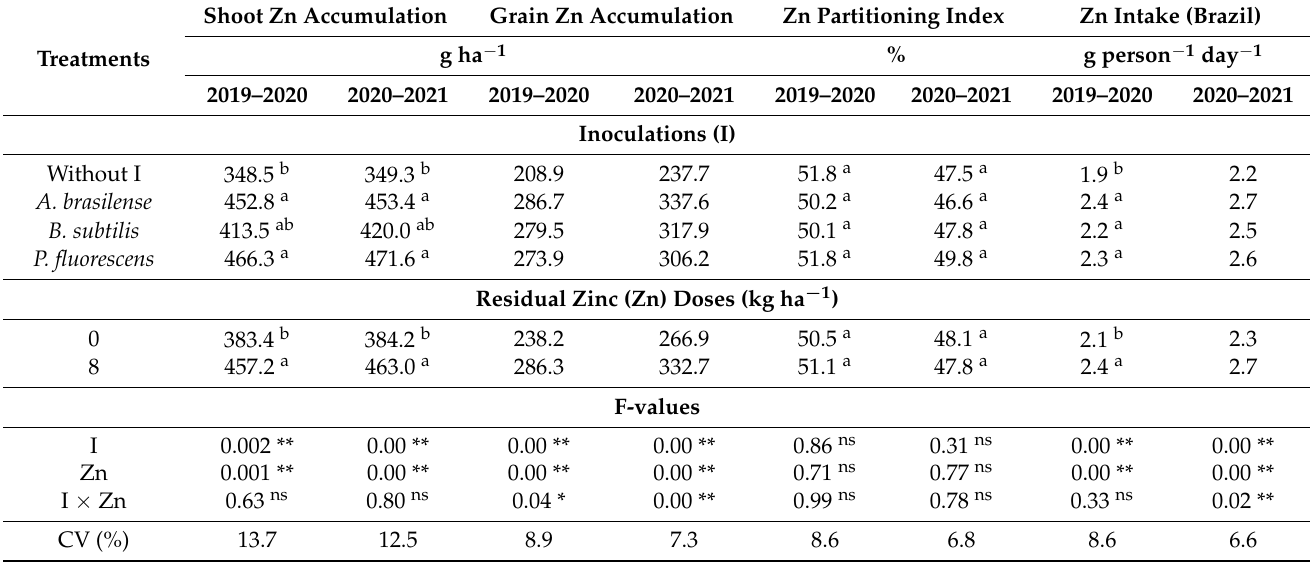
Table 3. Shoot and grain zinc accumulation, zinc partitioning index, and estimated daily zinc intake by maize in Brazil as function of residual zinc fertilization and diazotrophic bacteria inoculations